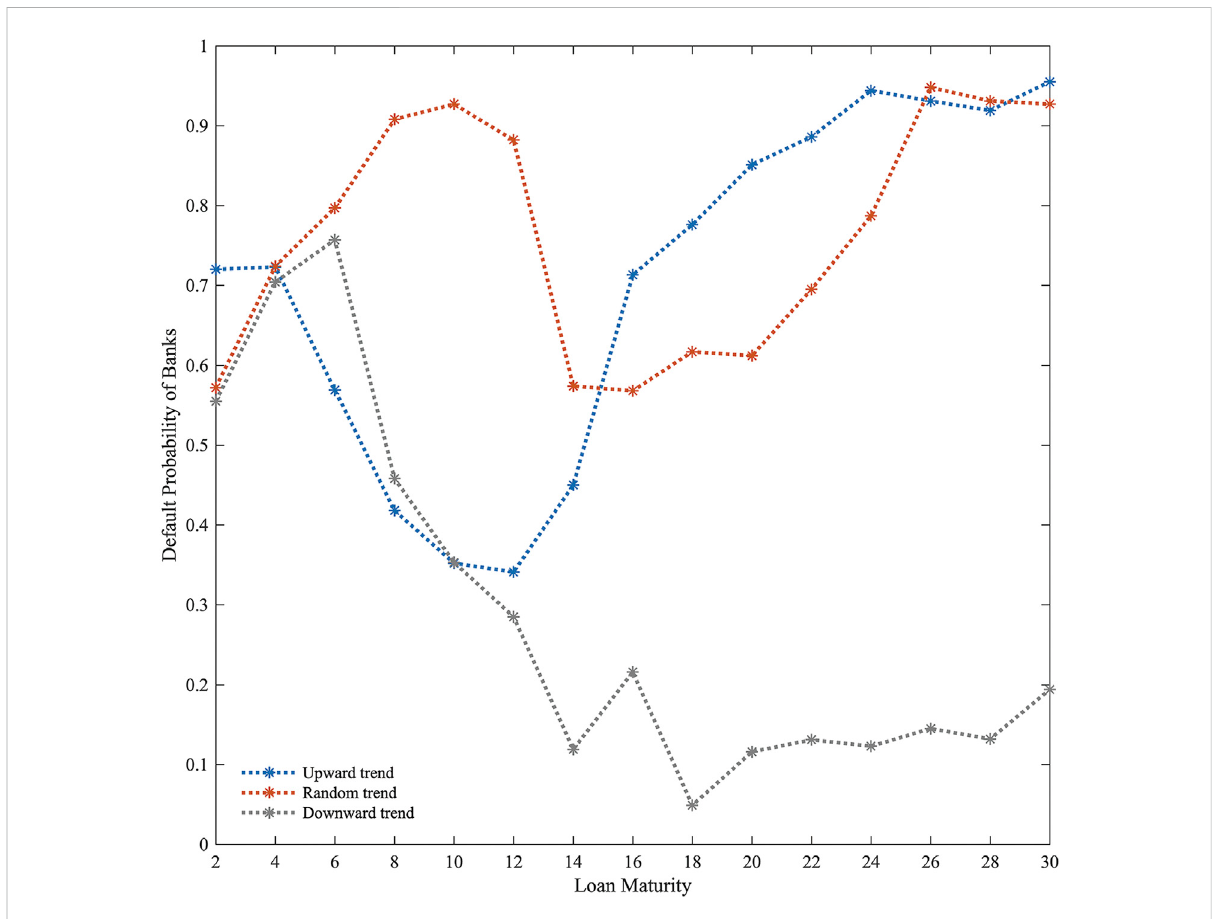
FIGURE 10 The default probability of banks with different loan